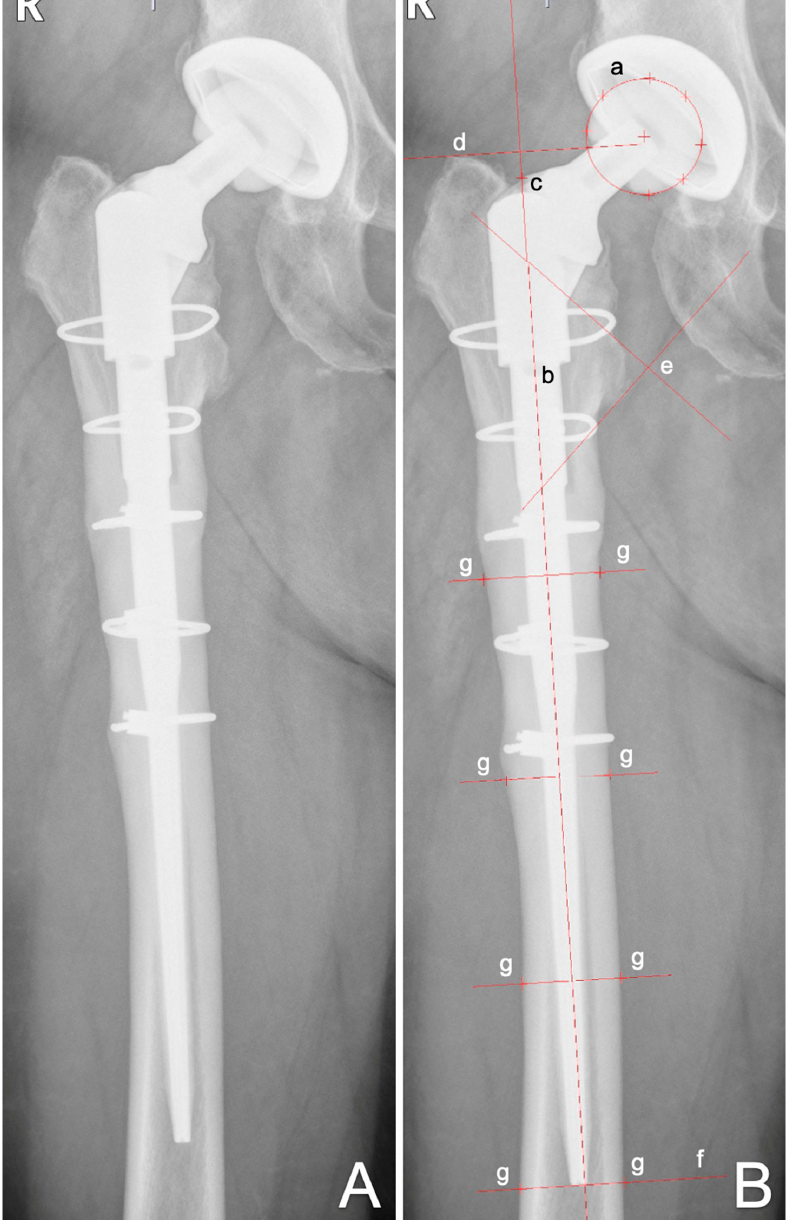
Figure 1. Anterior to posterior X-rays showing a cementless MP stem ( A ) and with EBRA-FCA references ( B ): (a) head points; (b) stem axis; (c) stem shoulder; (d) major trochanter line; (e) minor trochanter lines; (f) tip-of-stem line; (g) points at femoral bone contour.